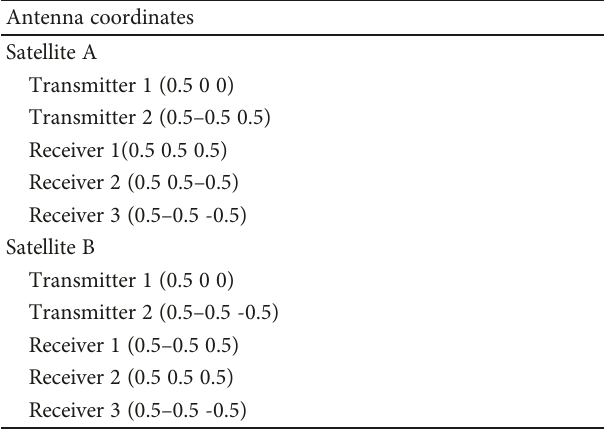
Table 1: Antenna coordinates of the tandem satellite. Antenna coordinates Satellite